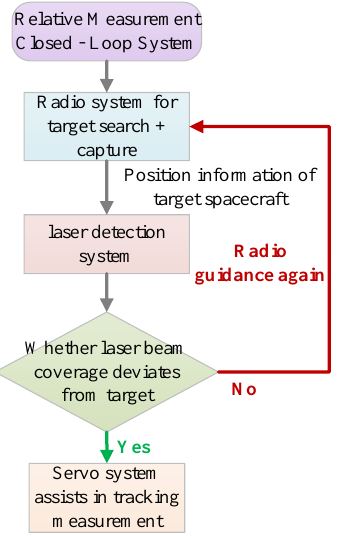
Figure 28. Radio + laser composite tracking measurement flow chart.